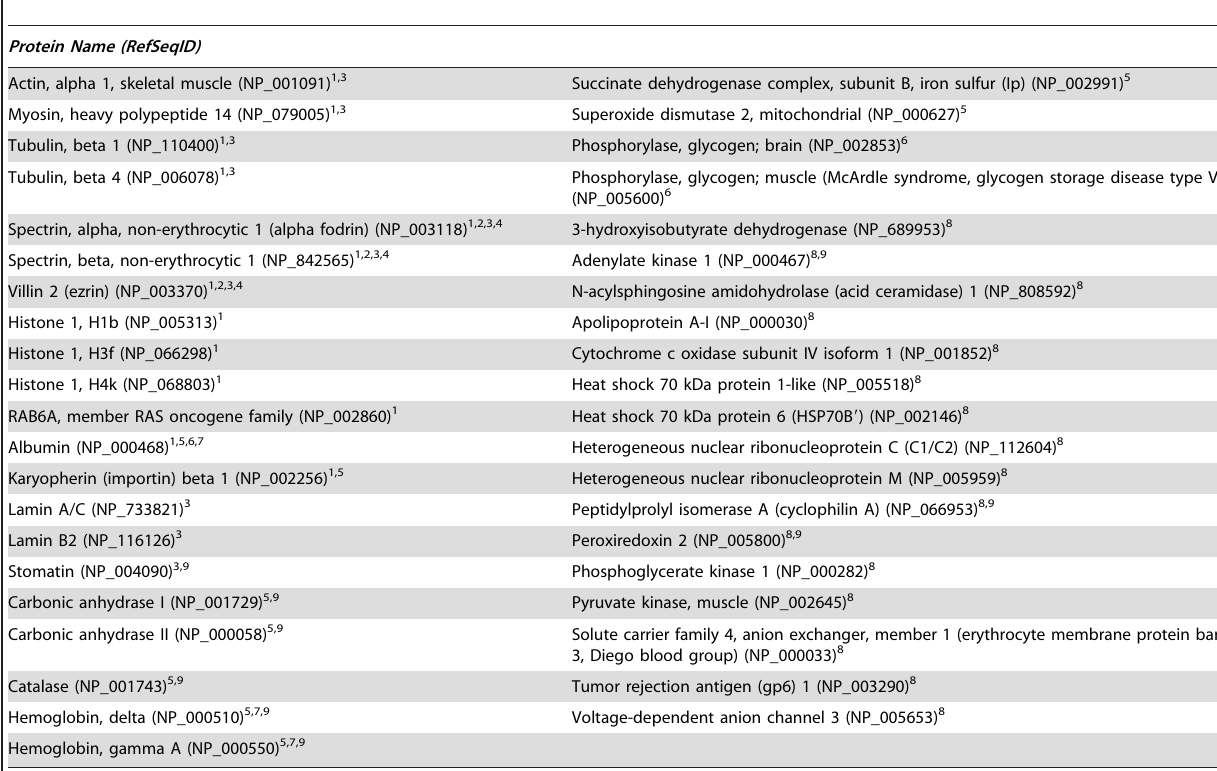
Figure 3. Comparison of individual protein detection and mRNA expression. Boxplots of the gene expression levels and bar graphs of LC- MS/MS results for A) ALDH3B1, B) hypothetical protein DKFZP586A0522, C) PLUNC, D) uteroglobin (CC10), and E) P4HB subunit. The borders of each boxplot represent the interquartile range of z-score normalized natural logarithm of the MAS5 gene expression data from this cohort of 5 never smoker and 5 current smokers, and from a previously published cohort (AGED) of 23 never smokers and 34 current smokers, excluding one never smoker in common to this study. The solid line within each box represents the median gene expression, and the whiskers of the plot extend to the upper and lower extremes of the data for each gene. Bar plots represent the number of smoker and nonsmoker samples in the current study where the protein was detected. Proteomic analysis detected ALDH3B1, hypothetical protein DKFZP586A0522, PLUNC and uteroglobin in more never smokers, while P4HB was detected in more current smokers. There is concordance in the direction of change for smoking-related protein and gene expression changes for these 5 genes. * p , 0.05. ** p , 0.005. *** p , 0.0005.